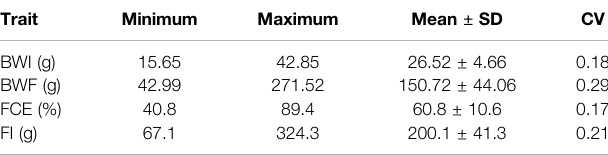
TABLE 1 | Descriptive statistics of phenotypic